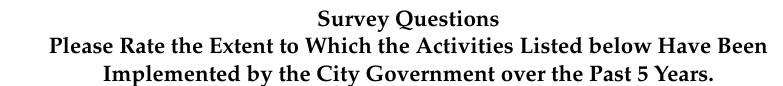
Table 1. Areas for assessing the city government’s commitment to residents’ healthcare, along with the survey questions assigned to them.